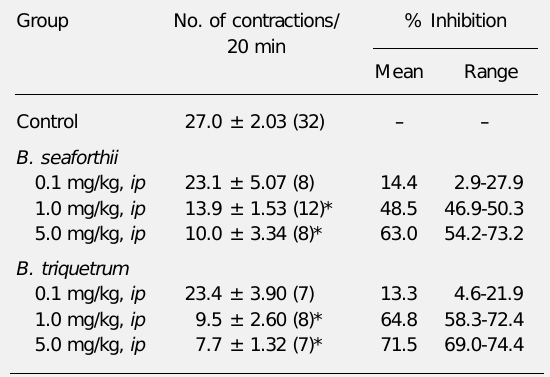
Table 3. Effect of carbohydrate fractions from Bryothamnion seaforthii and B. triquetrum on the acetic acid-induced abdomi- nal contractions in mice.